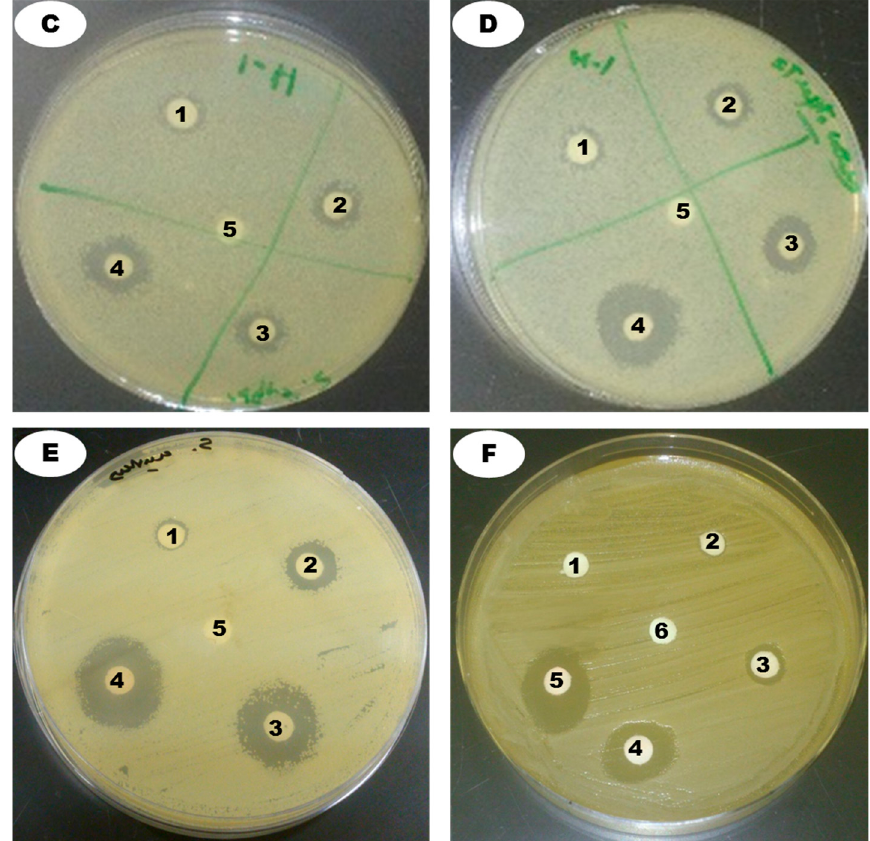
Figure 6. Antimicrobial activity of EtOAc extract of Streptomyces sp. strain ess_amH1 against bacterial pathogens: ( A ) K. pneumoniae ; ( B ) P. aeruginosa; ( C ) S. typhi; ( D ) S. pneumoniae; ( E ) S. aureus ; ( F ) C. albicans. For bacteria; 1 = 5 µg/disc, 2 = 10 µg/disc, 3 = 40 µg/disc, 4 = 80 µg/disc, and 5 = negative control DMSO; for fungi, 1 = 20 µg/disc, 2 = 40 µg/disc, 3 = 80 µg/disc, 4 = 200 µg/disc, 5 = 400 µg/disc, and 6 = negative control DMSO. Table 7. Antimicrobial activity of EtOAc extract of the strain ess_amH1 against some bacterial and fungal pathogens